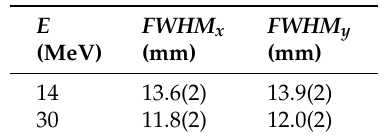
Table 1. Determined Beam size in x- and y- direction.